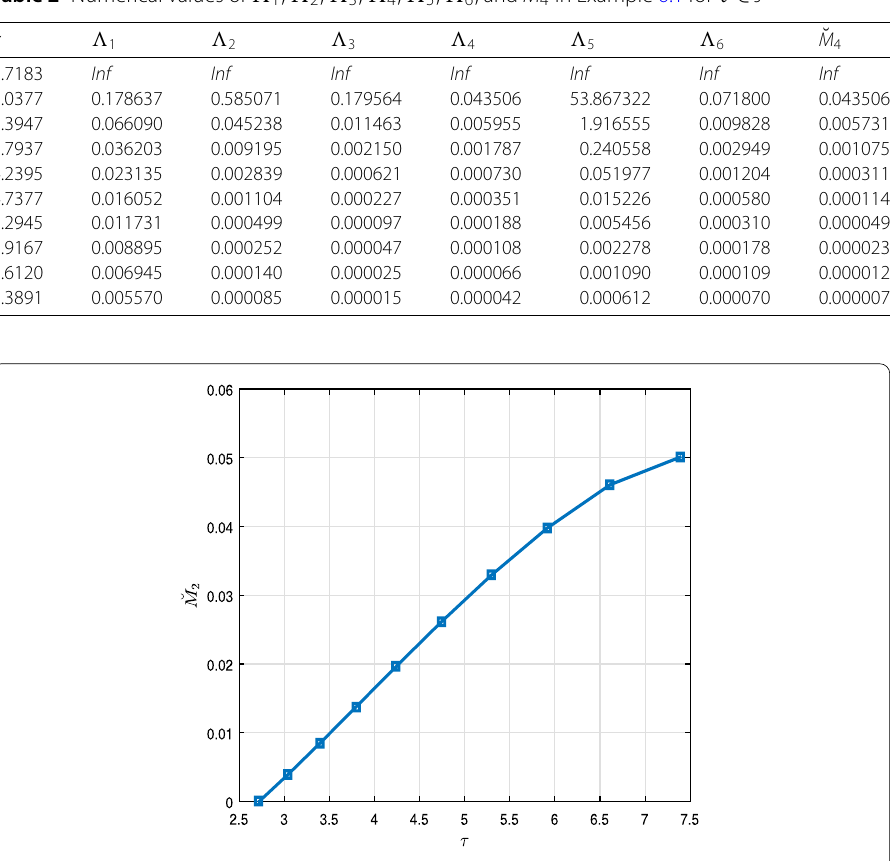
(cid:25) ` ι H ( ` a , ξ ) (cid:2) ( ξ ) d ξ , and ` a